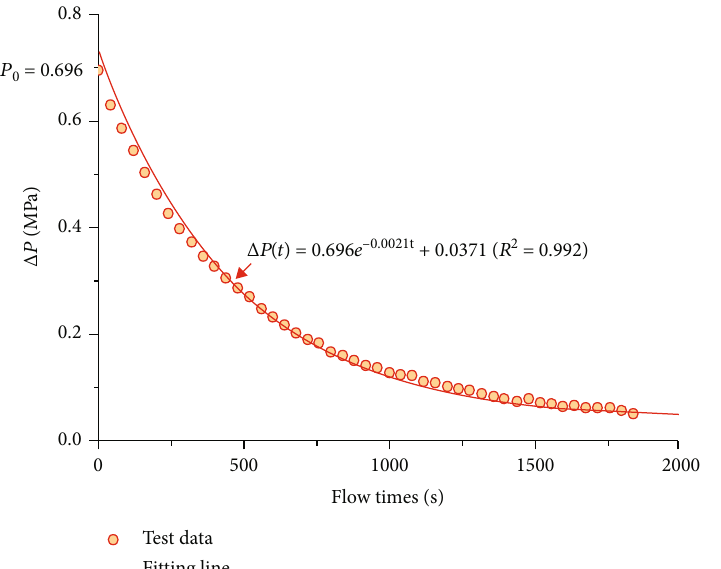
Figure 5: A representative di ff erential pressure versus fl ow time curve.